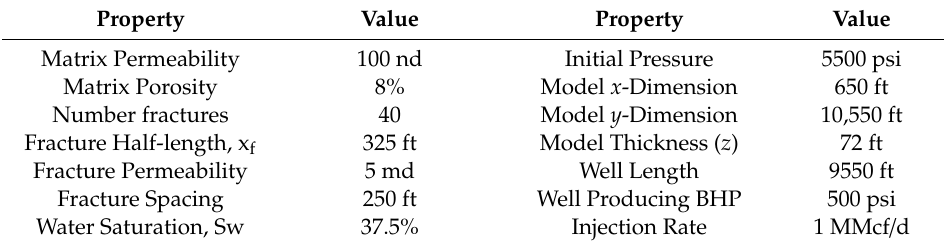
Figure 7. Model results (solid dark green line) history-matched to Eagle Ford huff-n-puff gas injection field pilot data from Hoffman [16] shown with light green line and symbols. Table 2. Reservoir model properties. BHP, bottom hole